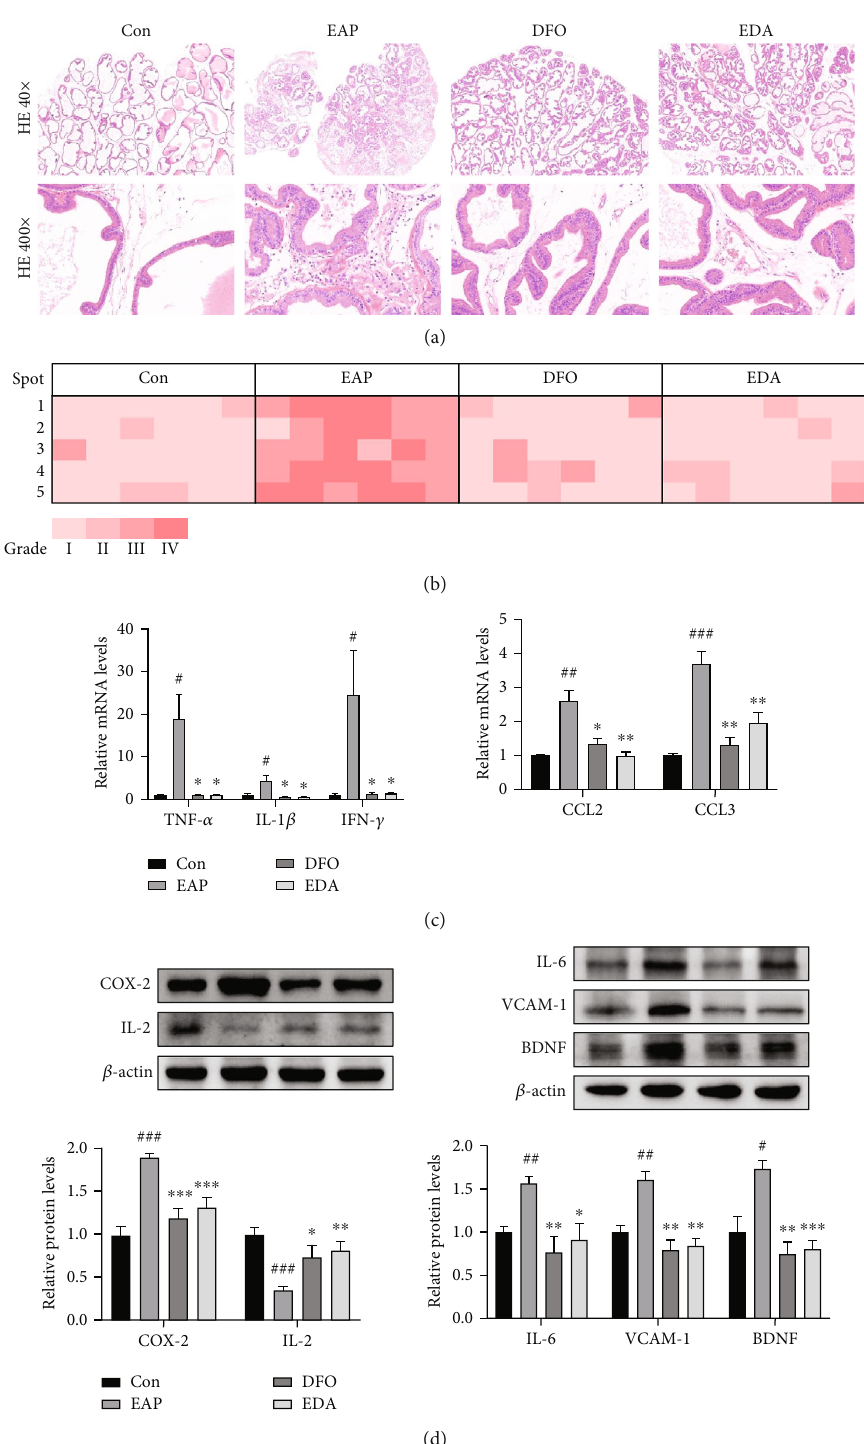
Figure 5: DFO and EDA alleviated the in fl ammatory responses in EAP model. (a) Representative HE-stained images of prostate tissues. (b) In fl ammation grades for prostate samples were scored on the basis of HE sections ( × 400 magni fi cation). The columns represent fi ve random spots of one rat, while the rows denote six animals involved in each group. (c) The mRNA expression of proin fl ammatory cytokines (TNF- α , IL-1 β , and IFN- γ ) and chemokines (CCL2, CCL3) relative to β -actin was performed by the RT-PCR method. (d) The protein levels of immunological mediators (COX-2 and IL-2) and cytokines (IL-6, VCAM-1, and BDNF) were performed using the western blot method, and the relative quantitative results are shown. Data was presented as mean ± SEM . # P < 0 : 05 versus the control group; ## P < 0 : 01 versus the control group; ### P < 0 : 001 versus the control group; ∗ P < 0 : 05 versus the EAP group; ∗∗ P < 0 : 01 versus the EAP group; ∗∗∗ P < 0 : 001 versus the EAP